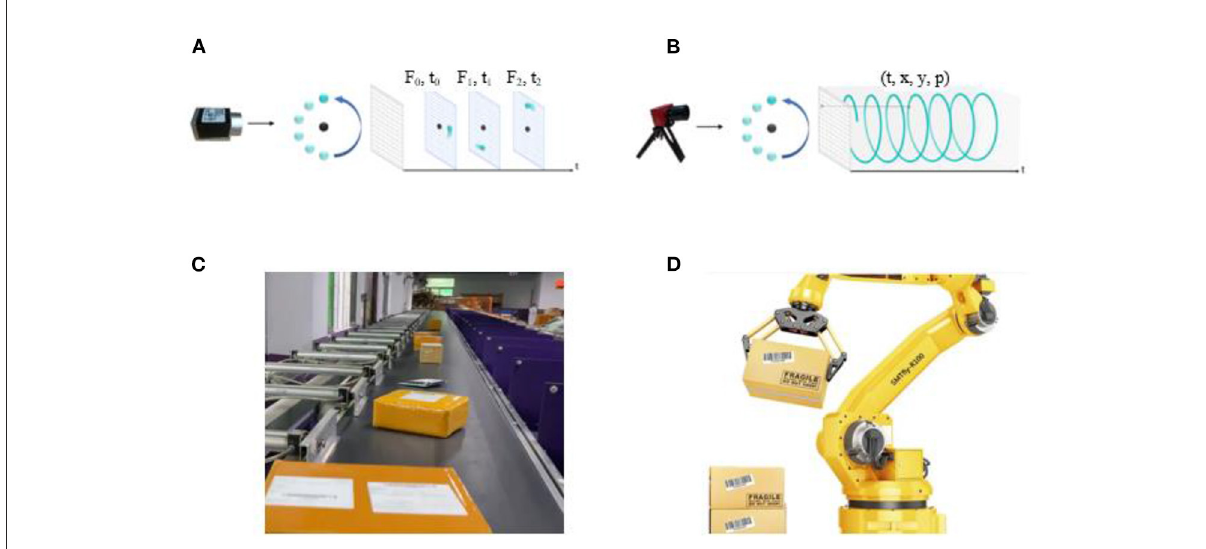
FIGURE1 (A) The frame-based camera captured the RGB pixels with a fixed frequency. (B) The NeuroVI camera captured the pixel events with low latency (Chen et al., 2020). (C) The delivery packages are needed to be grasped and sorted in the logistics center. (D) A robotic arm grasps the packages